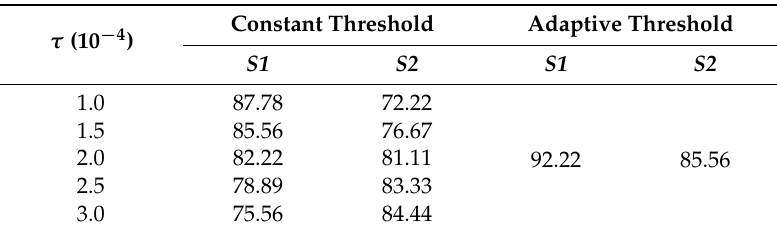
Table 2. The segmentation results with different threshold